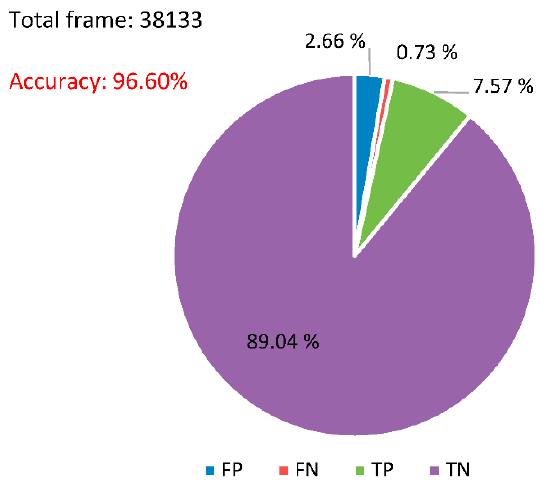
Figure 12. Results on benchmark 2.